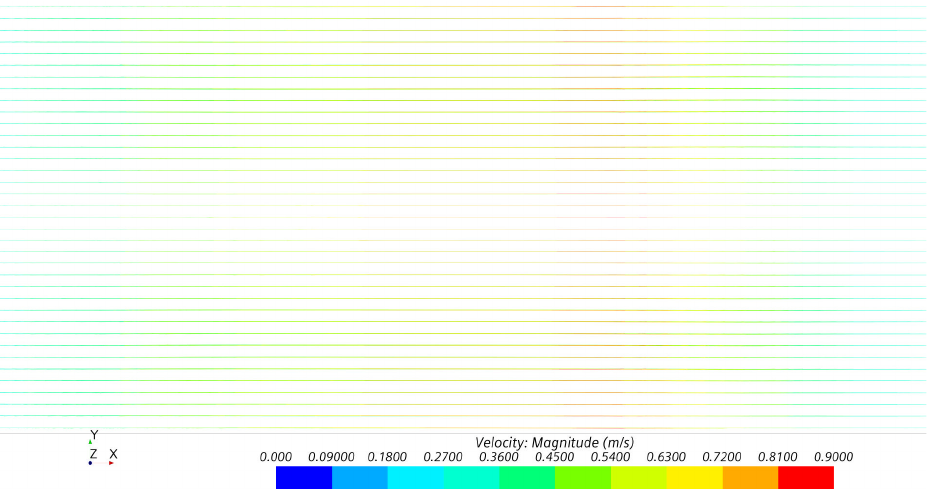
Figure 21. Flow velocities at z = − 0.074 m of the flow field without the tripod configuration, taken after a simulation time of 12.0002 s.